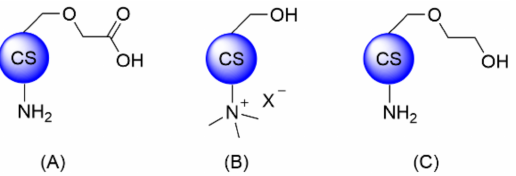
Figure 3. Structures of commercially available CS derivatives for further functionalization: ( A ) CMCS, ( B ) TMC, and ( C ) GCS.